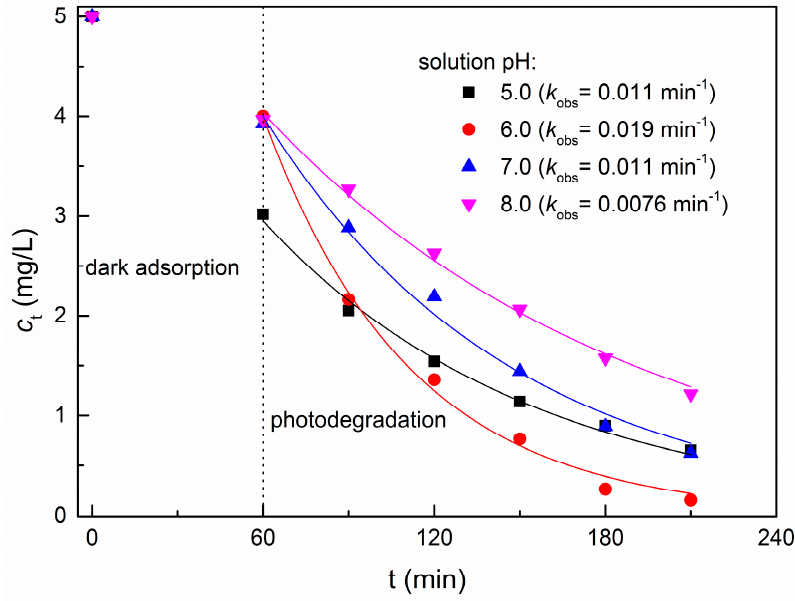
Figure 8. Effect of solution pH on the adsorption and photodegradation of MB dye on REC/Fe 3 O 4 /ZnO (1:0.3:0.5).